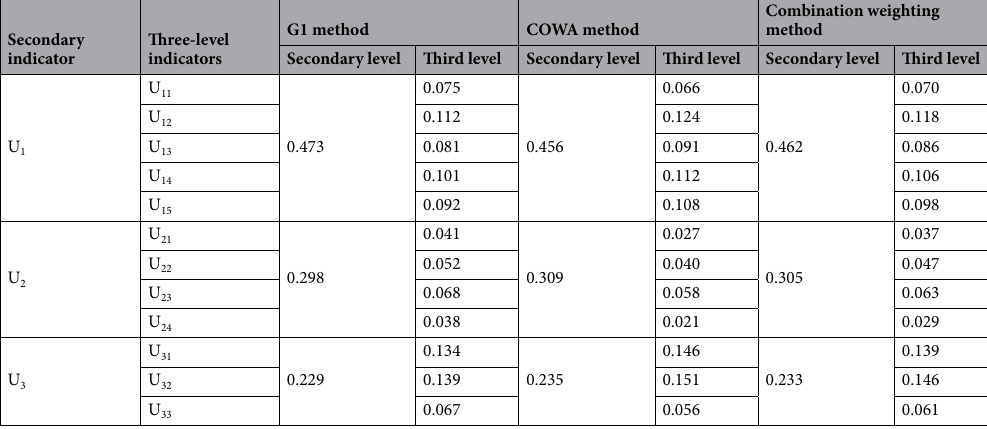
Table 3. Index weight and cloud numerical characteristics distribution of coal spontaneous